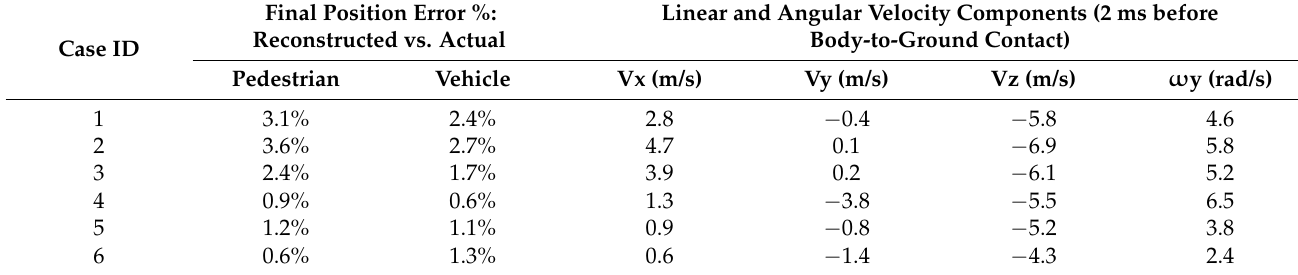
Table 2. Validation and extraction of reconstruction results